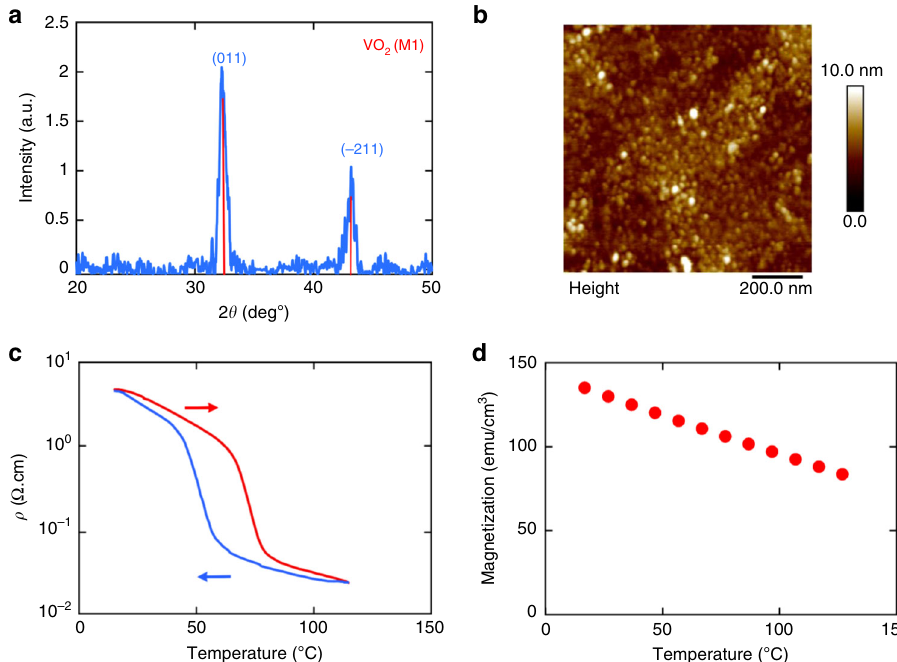
Fig. 1 Structural, electrical, and magnetic properties of VO2 (68 nm)/YIG bilayer. a θ − 2 θ X-ray diffraction scan (Cobalt source). b AFM image of VO 2 (68 nm) surface. c Resistivity vs. temperature showing a metal-insulator transition between 62 and 77 °C. d Temperature dependence of the magnetization in VO 2 (68 nm)/YIG(3 μ m) at 1 kOe as measured from